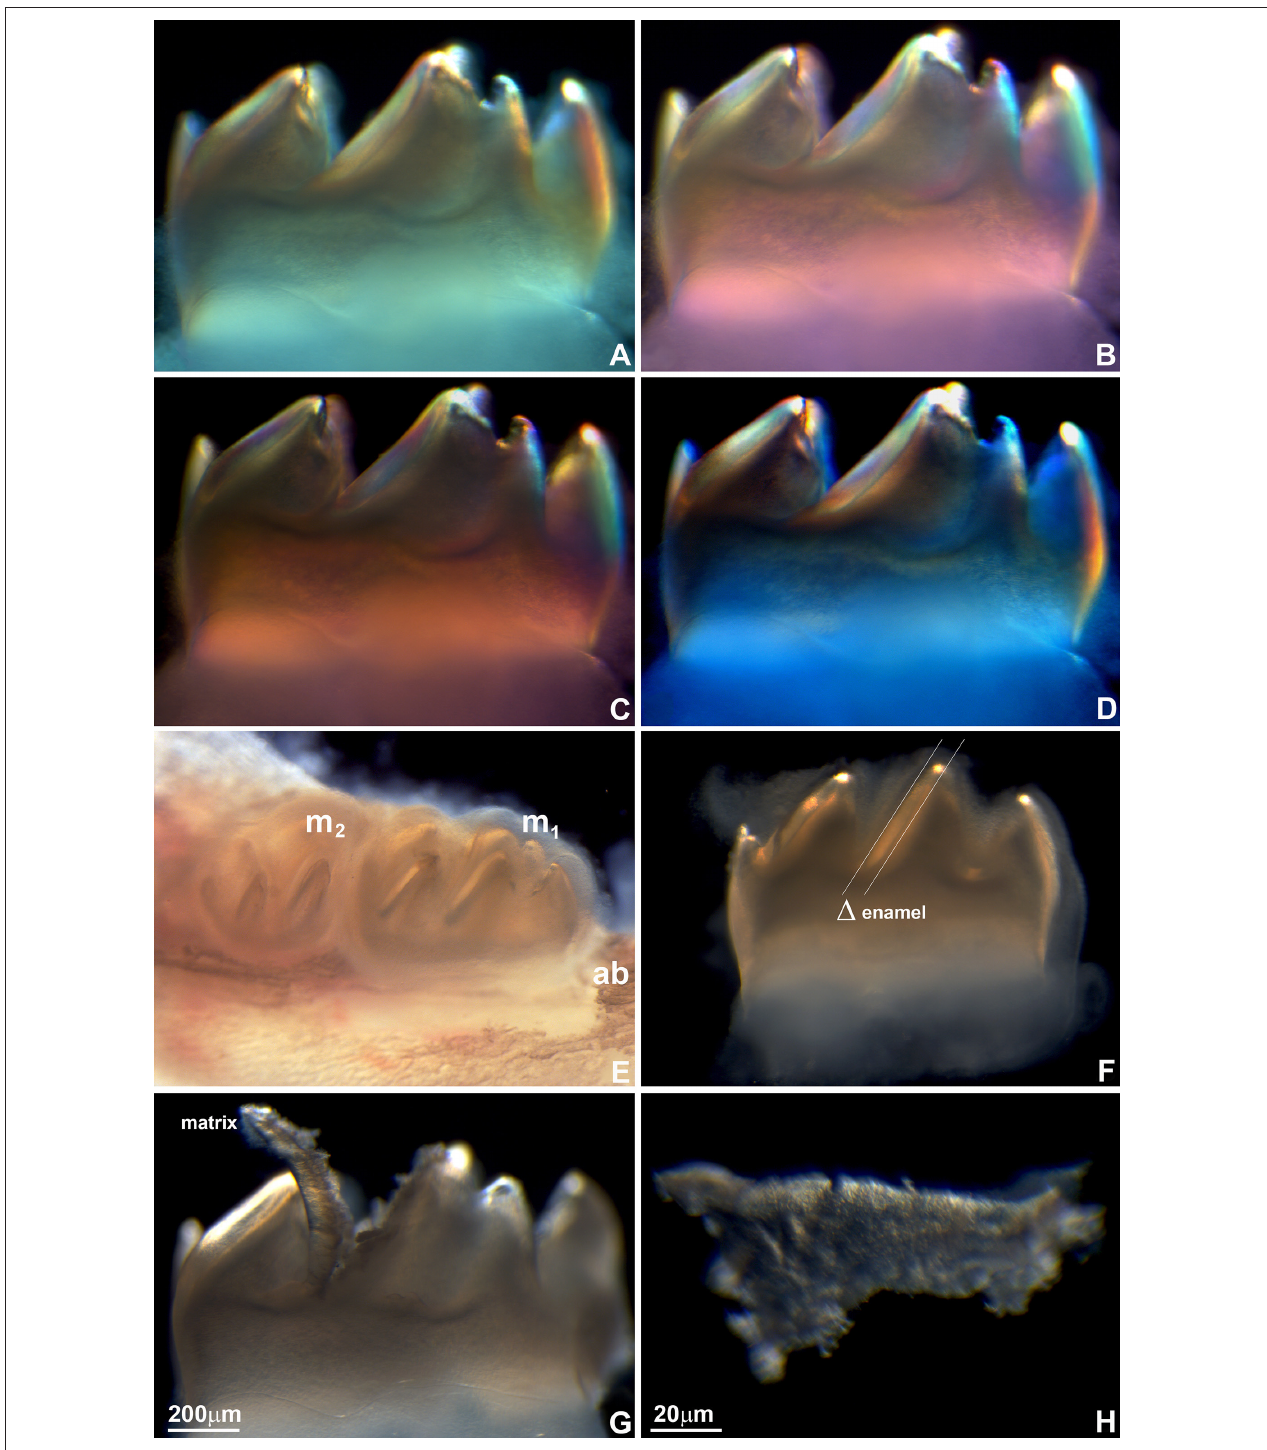
FIGURE 2 | Mouse molar enamel birefringence (A–D) and enamel matrix layer dissection for mineral and protein analysis (E–H). (A–D) Mouse molars were dissected from mouse jaws and placed between crossed polarizers. Polarizers were oriented at the following angles: 0 degrees (A), 90 ◦ (B), 180 ◦ (C), and 270 ◦ (D) . (E) Position of the first (m 1 ) and the second (m 2 ) mouse mandibular molar relative to the jaw bone and the alveolar bone (ab). (F) Enamel layer on the distal slope of the middle cusp of the first mandibular mouse molar used for the present analysis. 1 marks the thickness of the enamel layer between two parallel lines. (G) Preparation of the matrix layer from the distal slope of the middle cusp of the first mandibular mouse molar. (H) High magnification light micrograph of the dissected enamel layer.